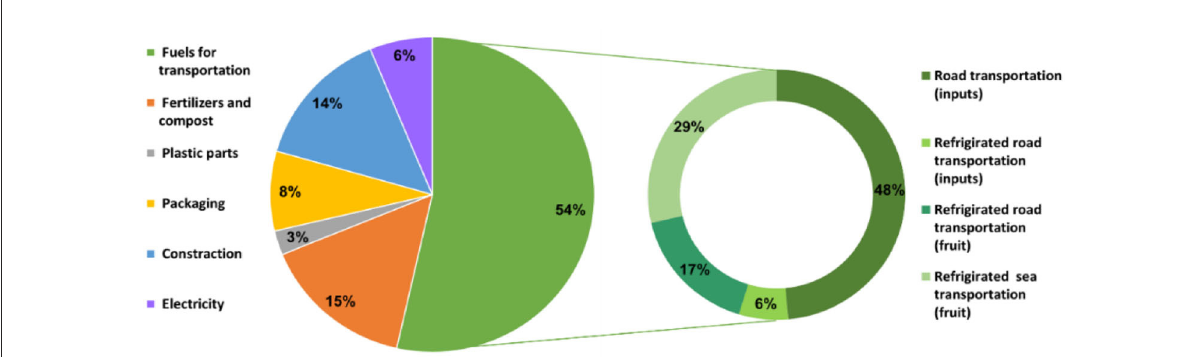
FIGURE4 Distribution of major inputs during the life cycle of PGH tomatoes. (Left) : Main components relative contributing to the average MF (per ton of greenhouse tomatoes), percentage out of total material inputs. The “electricity” factor refers to the amount of material needed to produce the electricity. (Right) : Breakdown of fuel consumption into the main operations and the estimated percentage contribution of each operation to the total fuel inputs throughout the PGH tomatoes’ life